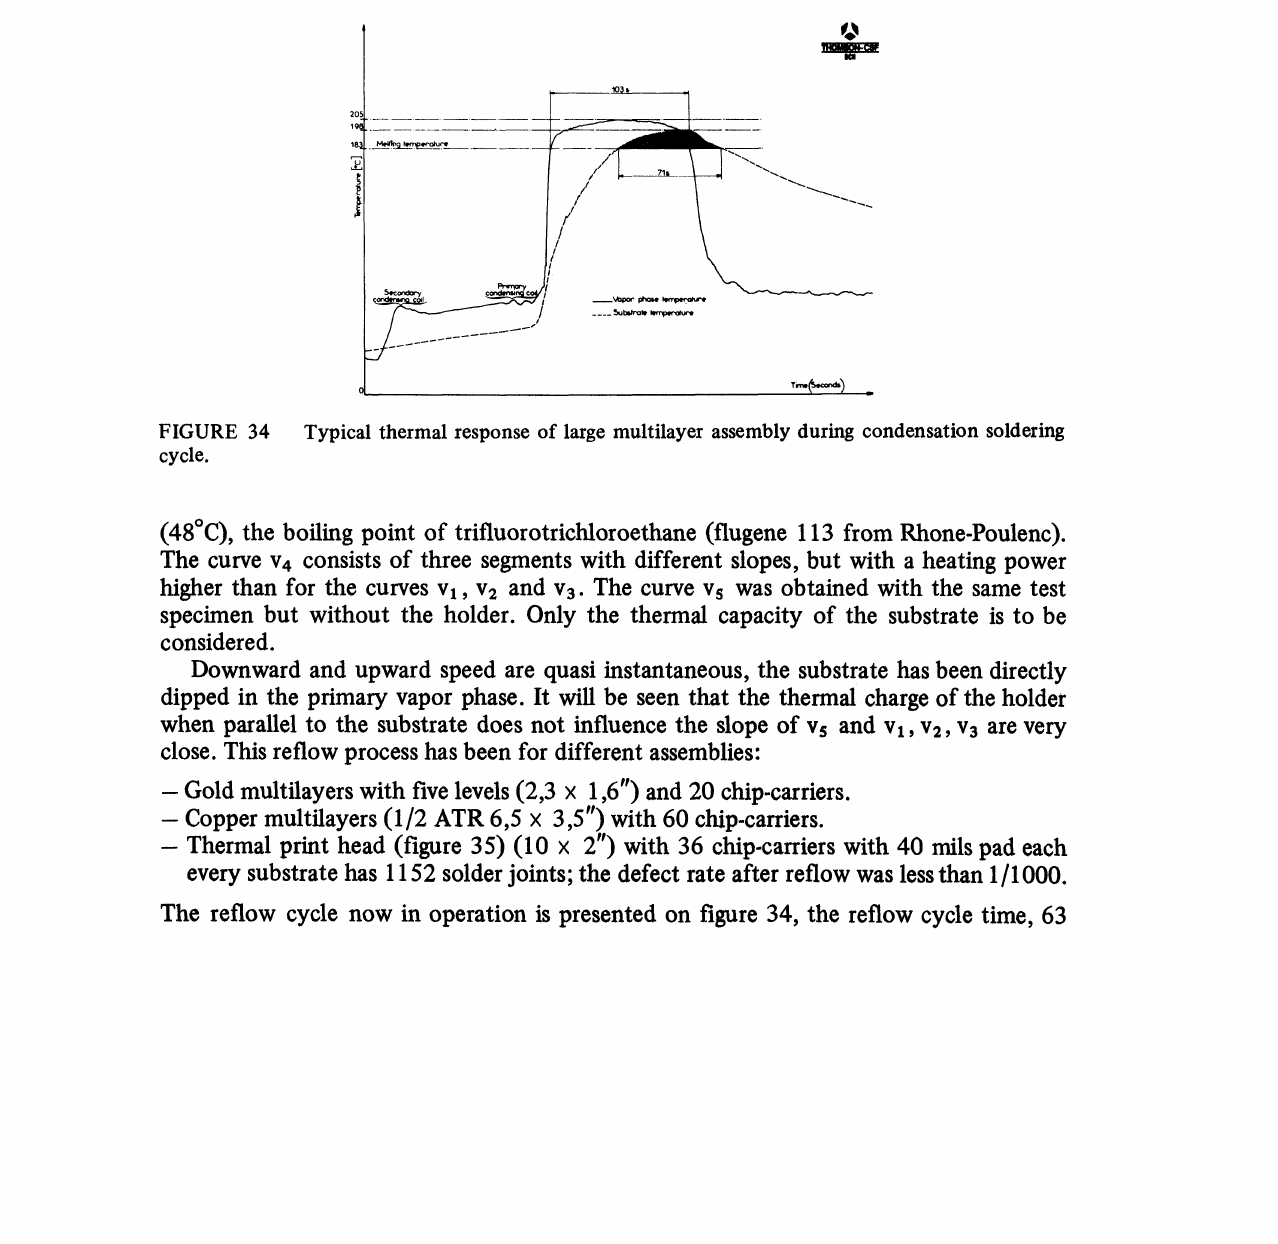
FIGURE 33 Temperature Vs time.